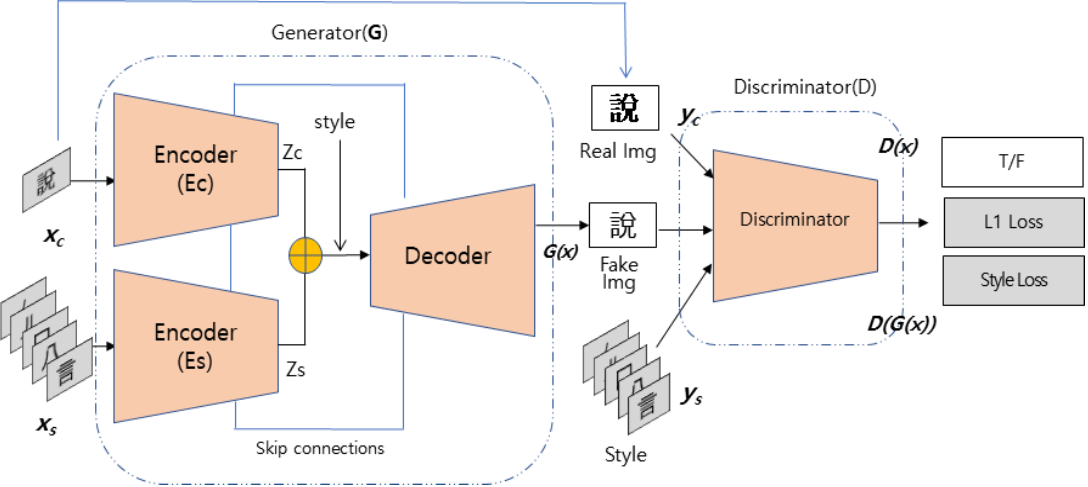
Figure 11. CCFont model architecture.